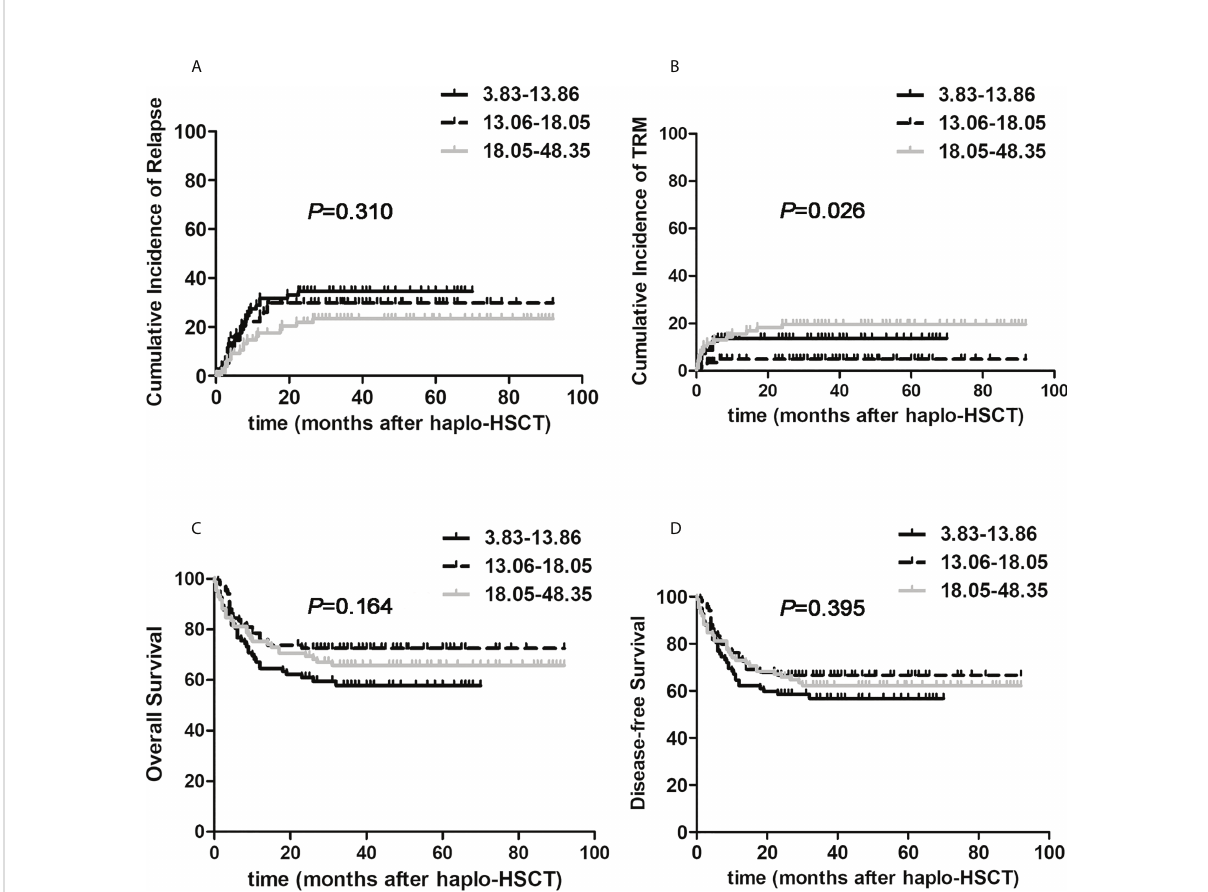
FIGURE 2 The effects of total nucleated cells on post-transplant outcomes of patients with hematological malignancies undergoing ATG-based haplo- HSCT. The number of infused total nucleated cells was divided into three subgroups according to the number of infused total nucleated cells: 3.83-13.06×10 8 /kg (the black solid line, n=84), 13.06-18.05×10 8 /kg (the black dotted line, n=83), 18.05-48.35×10 8 /kg (the gray solid line, n=84). (A) relapse; (B) TRM; (C) Overall survival; (D) Disease-free